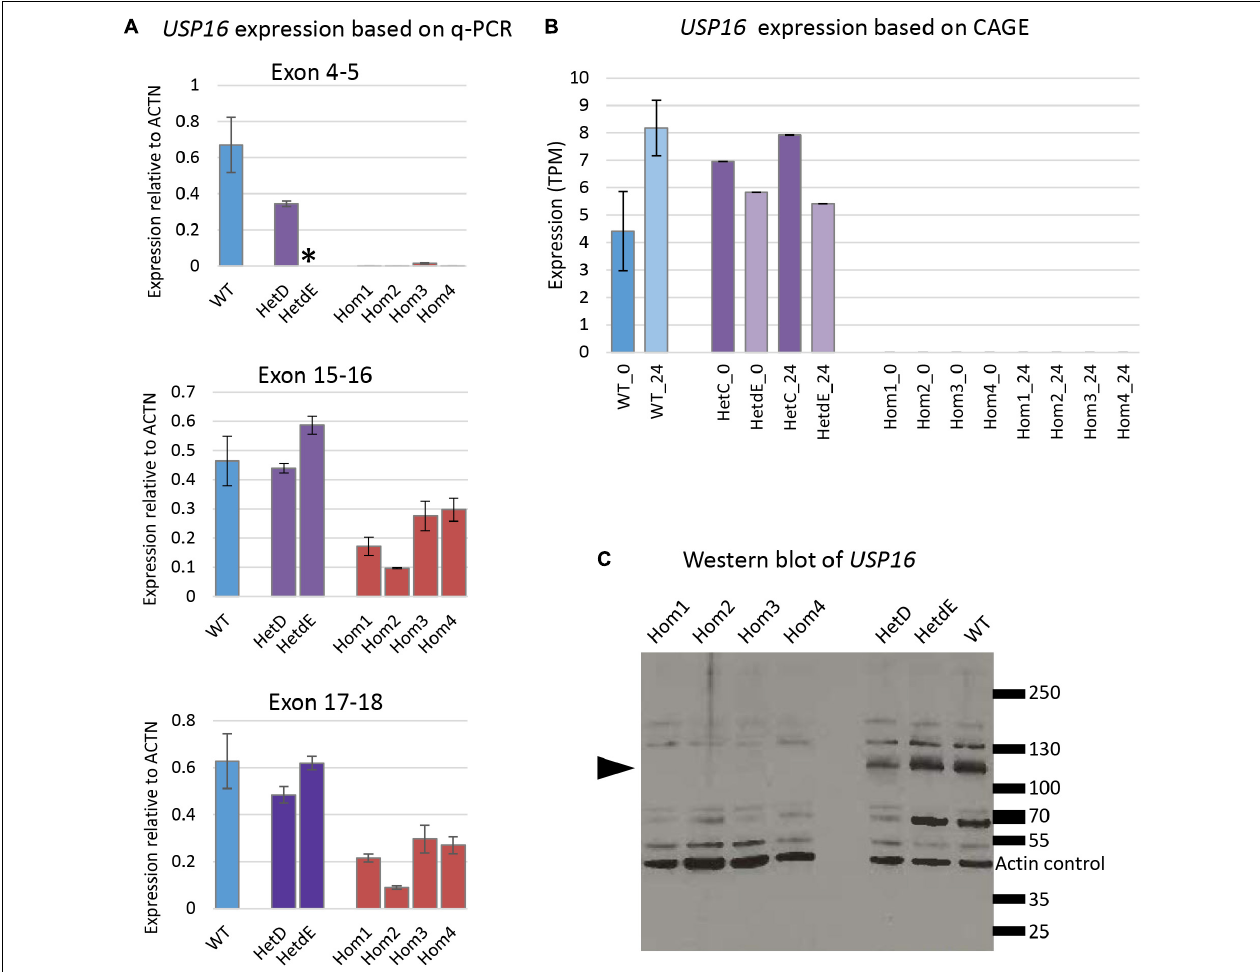
FIGURE 2 | USP16 expression in edited clones. (A) Quantitative PCR for three sets of USP16 primers, targeting different exons. RNA was from undifferentiated cells. Blue – wild type; purple – heterozygotes; red – homozygotes. Y -axis shows the Roche ratio normalized by ACTB expression with error rates calculated by Roche LightCycler480 software. Error bars show standard error. Asterisk shows technical failure of qPCR for HetdE. All assays were carried out in duplicate. Homozygotes were significantly different from wild type (all p < 10 − 7 ); heterozygotes were not significantly different from wild type. (B) USP16 expression derived from transcriptomic analysis using CAGE. Expression levels are shown for control untreated cells (darker columns) and cells after 24 h of PMA stimulation (lighter columns). Blue – wild type; purple – heterozygotes; values in homozygotes were all 0. Homozygotes were significantly different from wild type ( p = 0.03 at 0 h and p = 0.004 at 24 h). Heterozygotes were not significantly different from wild type at either time point. (C) Western blotting for USP16 and actin in extracts of THP-1 clones. Lanes 1, 2, 3, and 4 are USP16 knockout homozygotes; lanes 6 and 7 are USP16 knockout heterozygotes, and lane 8 shows the wild type THP-1 cell line. Molecular weight ladder sizes (kDa) are shown to the right of the image. Actin loading control bands of 42 kDa are indicated. All other bands were detected by anti-USP16 antibody (ab121650). Bands of around 120 kDa (present in heterozygotes and wild type) were not present in the four homozygous USP16 knockout THP-1 clones